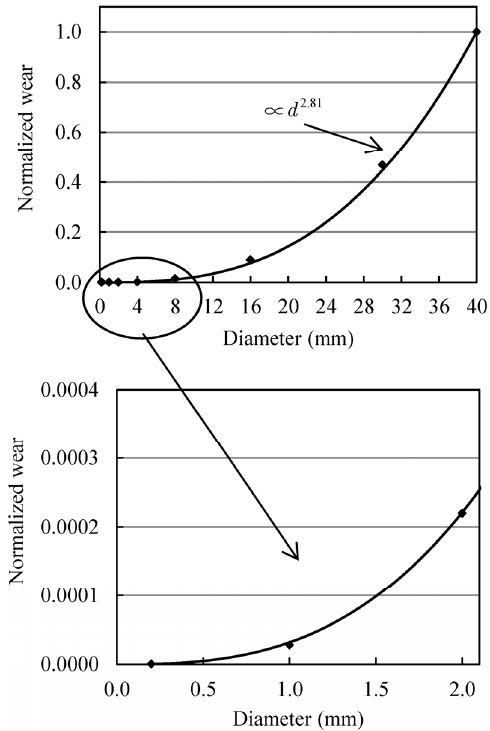
Fig. 6 Variation of the wear versus the diameter of the impacting particle (  40° and the other variables are at the reference